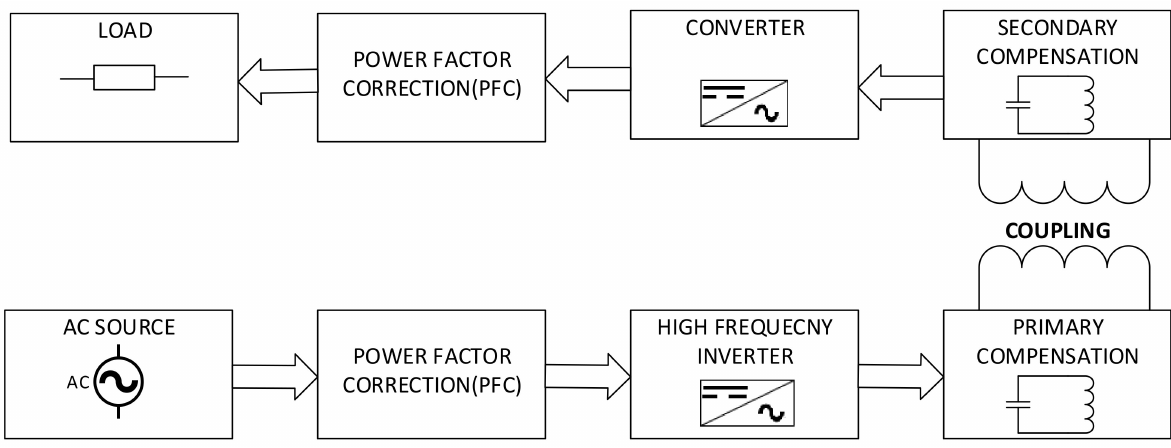
Figure 5. Block diagram of an IPT